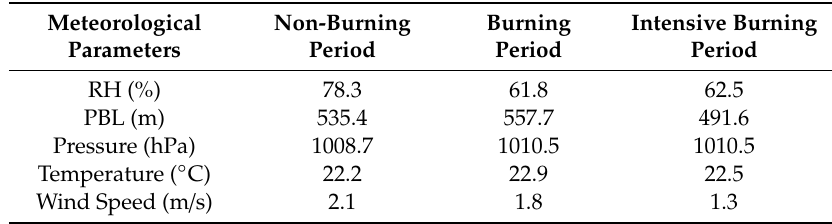
Figure 4. Variation of meteorological factors (Pressure, BLH, temperature, RH and wind speed) in the study area from September to October 2015. Table 3. Statistical summary of the average value for meteorological factors (RH, PBL, pressure, temperature and wind speed) in different periods.